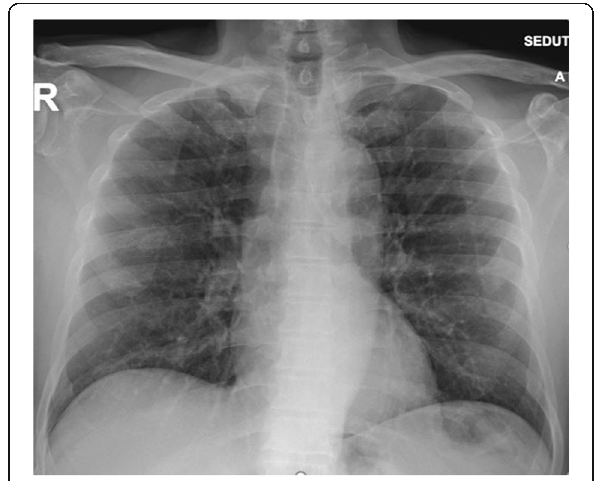
Fig. 5 Chest RX, PA projection (April 21). No evidence of pleuro- parenchymal alterations in both lung